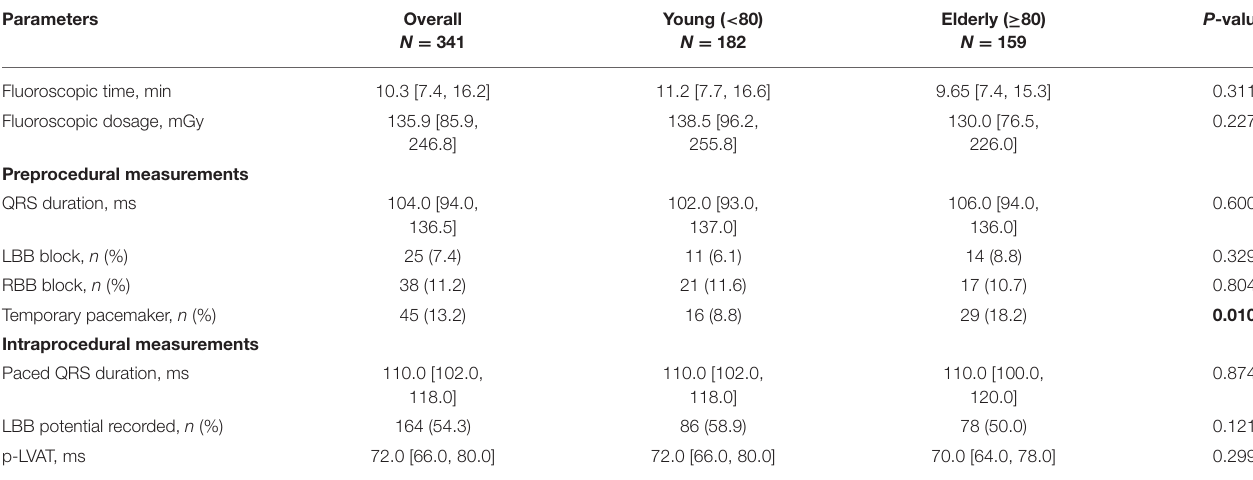
TABLE 2 | Procedural details of LBBP.